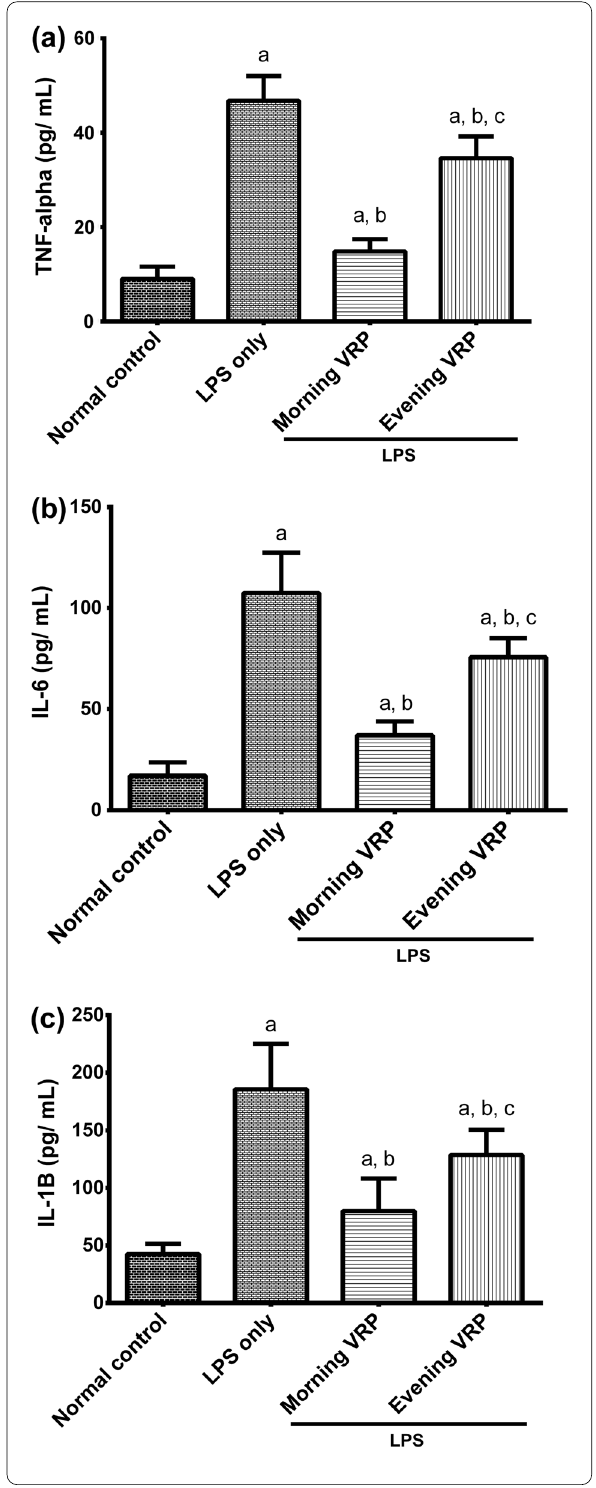
Fig. 5 Effect of VRP on inflammatory cytokines. a TNF-α, b IL-6, and c IL-1β. Data are expressed as the mean SD and were analyzed ± using one-way ANOVA followed by Tukey post hoc test. Values were considered significantly different at P < 0.05. a: significant versus normal control, b: significant versus LPS only, and c: significant